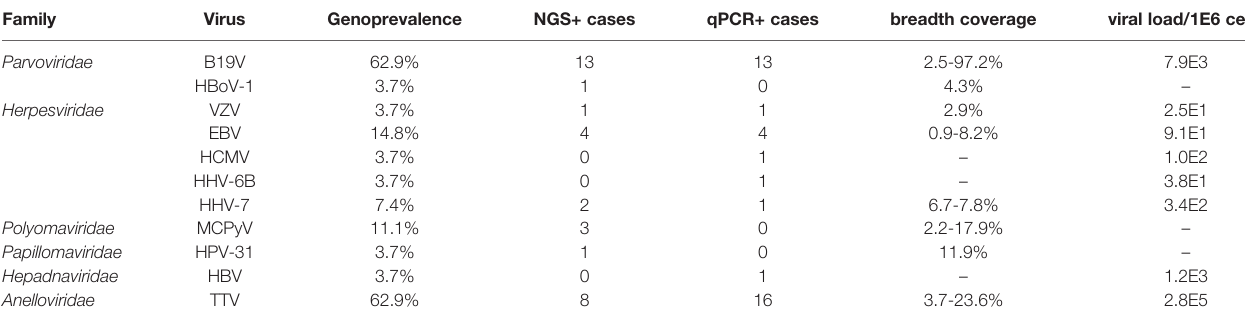
TABLE 1 | DNA virus fi ndings from human bone marrow. Family Virus